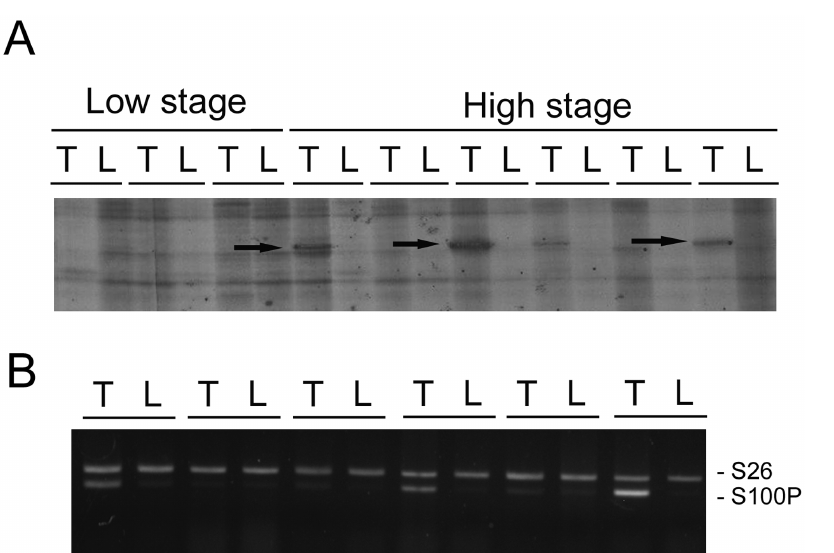
Figure 1. Identification and confirmation of overexpression of S100P in HCC. (A) Differential display showed that S100P expression was upregulated in high-stage HCCs. The arrows indicate bands of S100P, which was confirmed by subsequent cloning and sequencing. T: hepatocellular carcinoma; L: non-cancerous liver parenchyma. (B) Expression of S100P mRNA in paired HCC (T) and non-cancerous liver parenchyma (N). RT-PCR measurement identified S100P overexpression in 3 of 6 HCC specimens.